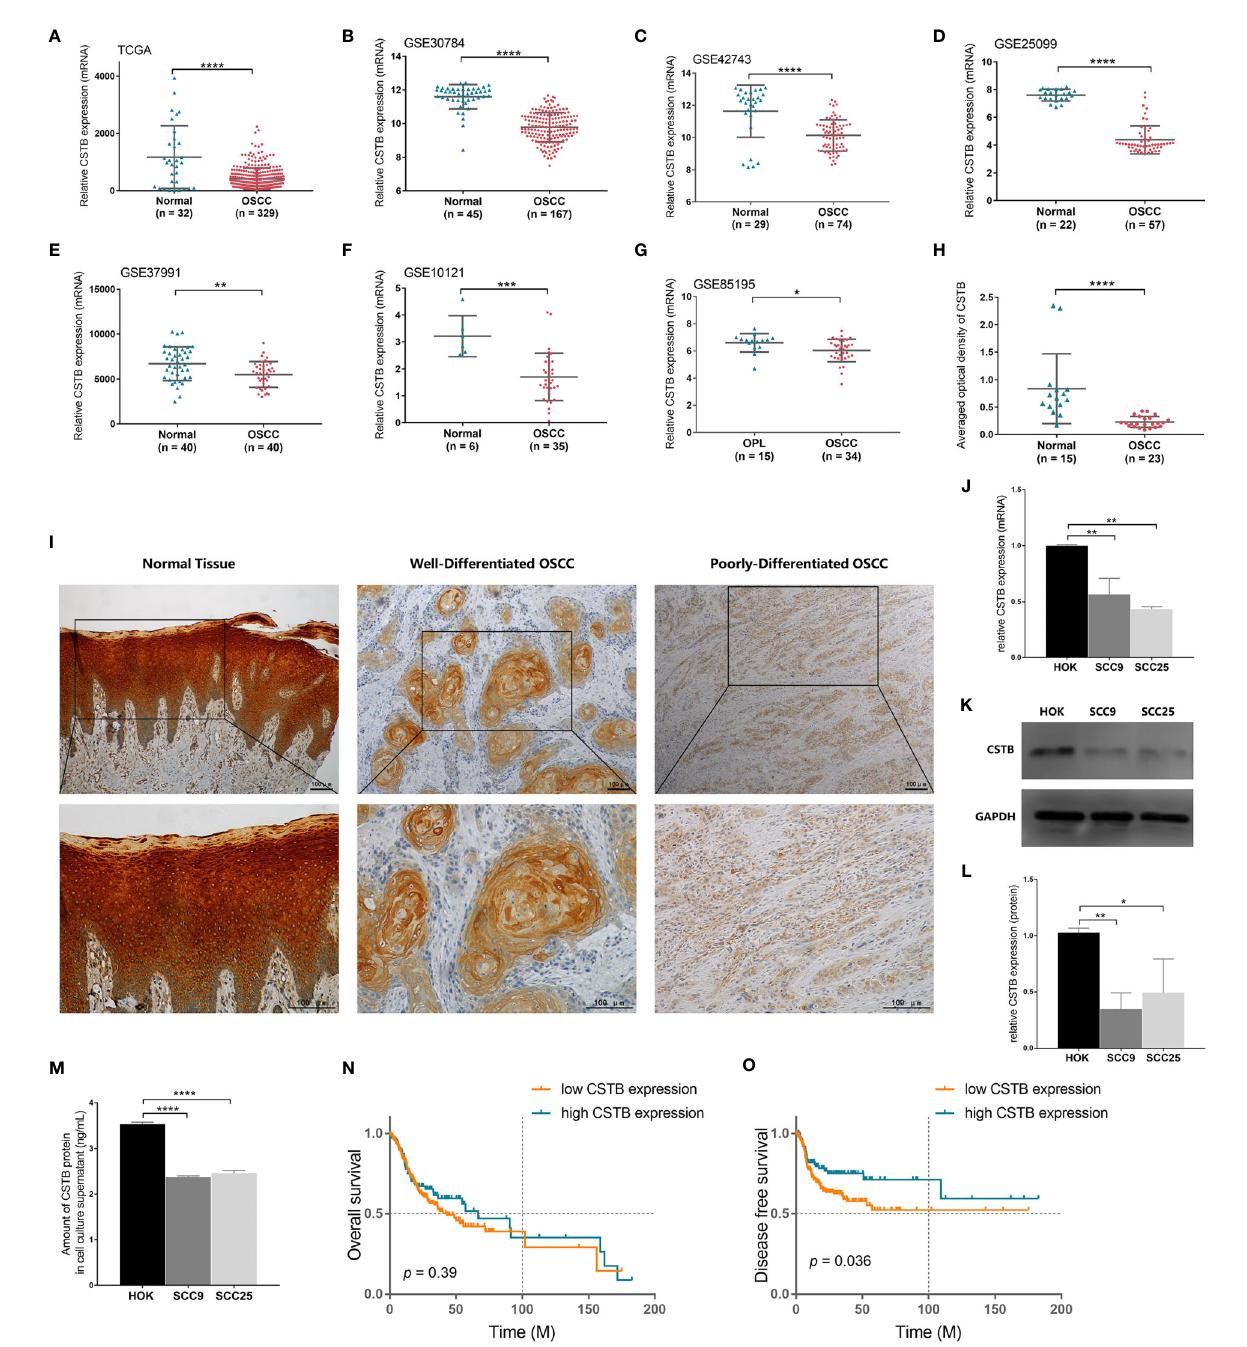
FIGURE 2 | CSTB is downregulated in OSCC and is associated with poor prognosis. Relative expression of CSTB mRNA in OSCC tissues ( n = 329) and matched normal tissues ( n = 32) from the TCGA database. (B – F) Relative expression of CSTB mRNA in OSCC tissues and normal tissues from the GEO database. The sample size of each group is shown in the fi gures. (G) Relative expression of CSTB mRNA in OSCC tissues ( n = 34) and oral leucoplakia (OPL) tissues ( n = 15) from the GEO database. (H) Average optical density of CSTB in normal ( n = 15) and OSCC ( n = 23) tissues in IHC analysis. (I) IHC staining of CSTB in normal and OSCC tissues. Magni fi cation at ×100 (upper panel) and ×200 (lower panel); scale bars, 200 m m. (J) The relative expression of CSTB mRNA in the oral epithelial keratinocyte line and OSCC cell lines was quanti fi ed by RT-qPCR. (K, L) CSTB protein expression in the oral epithelial keratinocyte line and OSCC cell lines was identi fi ed by Western blot analysis (K) and quantitatively analyzed (L) . (M) The content of CSTB in the culture supernatant in the oral epithelial keratinocyte line and OSCC cell lines was quanti fi ed by ELISA. (N, O) Kaplan-Meier survival curves of overall survival and disease-free survival in the high and low CSTB expression groups. Error bars represent the standard deviation. * p < 0.05, ** p < 0.01, *** p < 0.001, **** p <